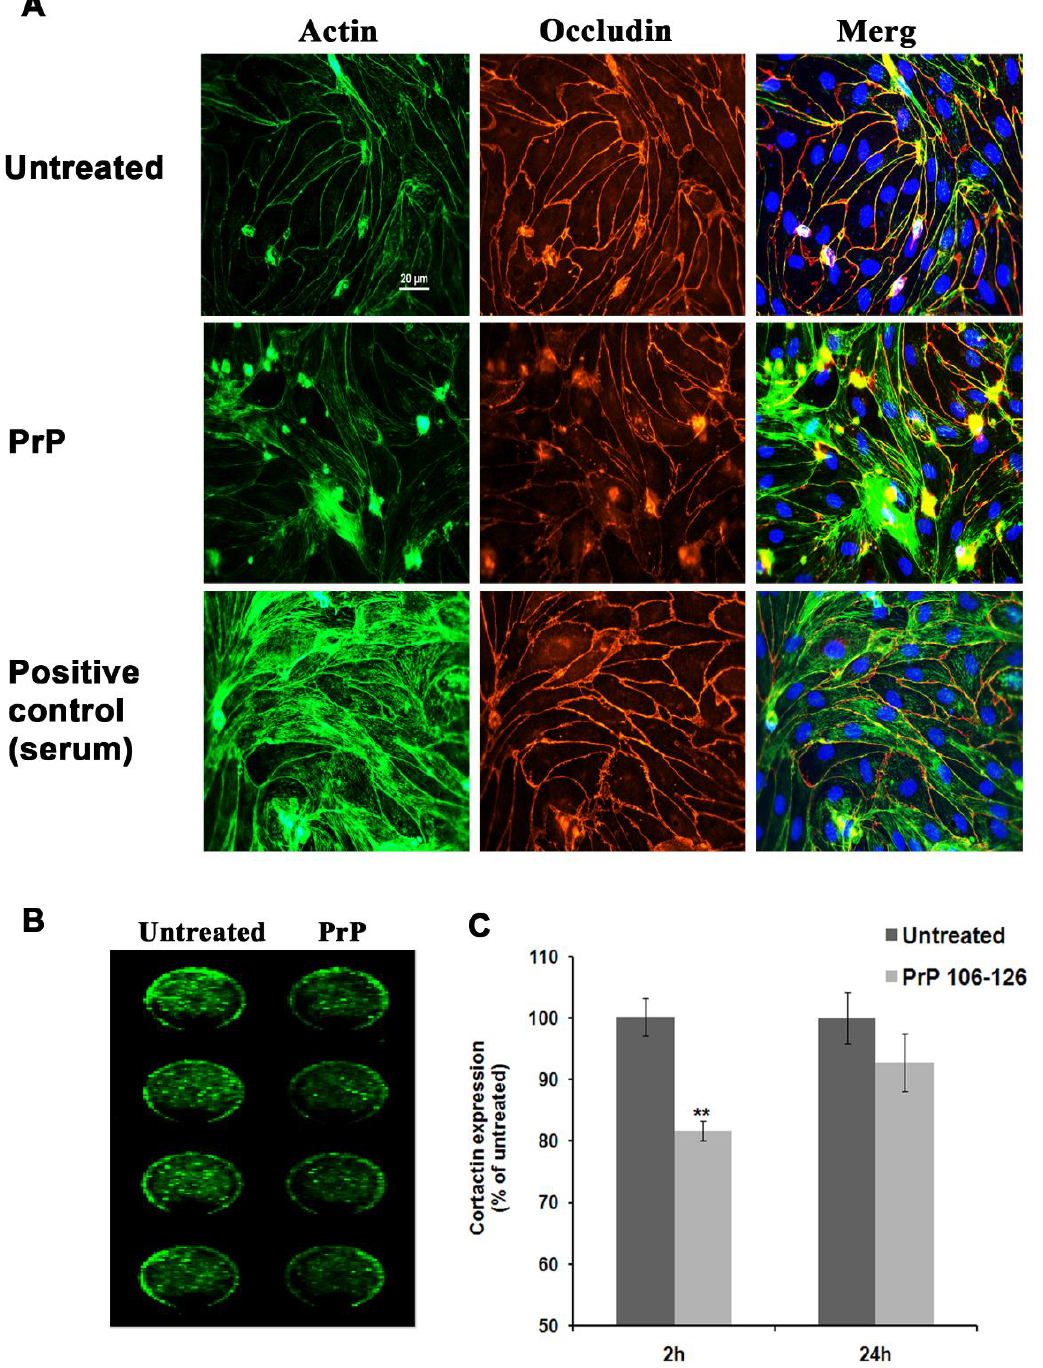
Figure 4. Stress fibers formation and cortactin expression levels in brain endothelial cells exposed to PrP 106-126. ( A ) Stress fibers formation after PrP 106-126 treatment is shown in PFA fixed PBEC monolayers after 24 h exposure to 100 µM PrP 106-126 in assay medium or plating medium which contains 10% serum for positive control. ( B ) In-cell western blot showing a reduction in cortactin protein levels after 2 h treatment with 100 µM PrP 106-126. An image from the Odyssey infra-red detector is shown. ( C ) Quantification of B. After 2 h exposure to PrP 106-126 a statistically significant difference between the treated and untreated groups was found. The reduction after 24 h was not statistically significant. Results are expressed as the mean ± SEM ( n = 4). ** p < 0.01, compared with untreated cells normalized to total cell proteins staining (Section 4).